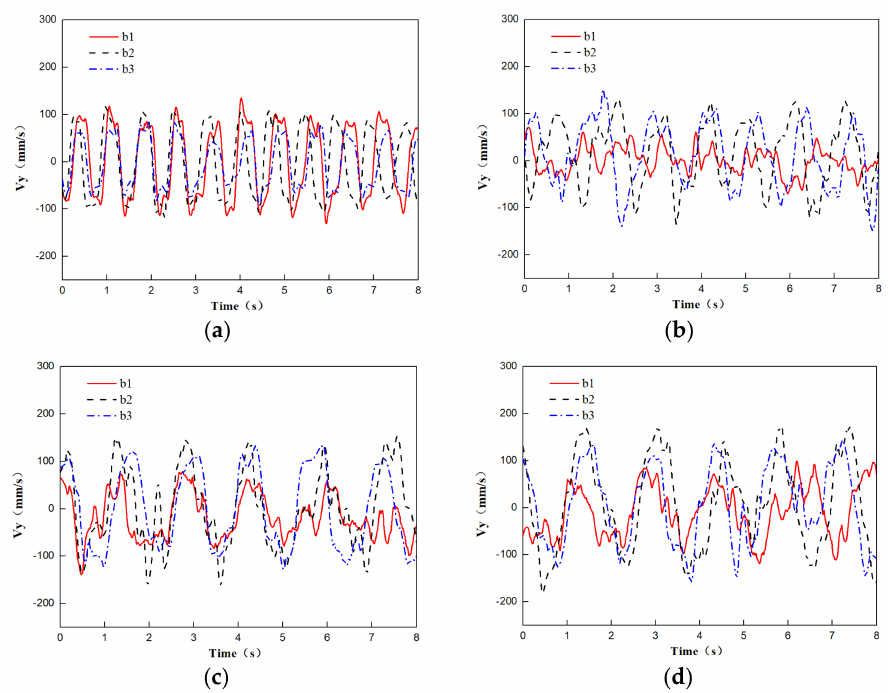
Figure 11. Transverse velocity duration curves downstream of bridge pier: ( a ) α = 0 ◦ ; ( b ) α = 15 ◦ ; ( c ) α = 30 ◦ ; ( d ) α = 45 ◦